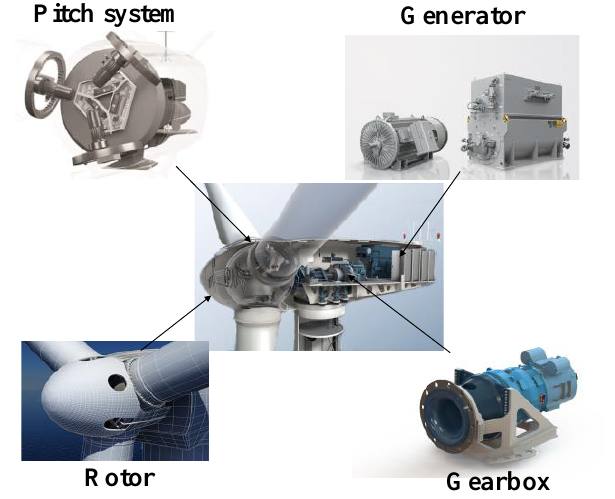
Figure 1. Components of the offshore wind turbine (OWT) system.